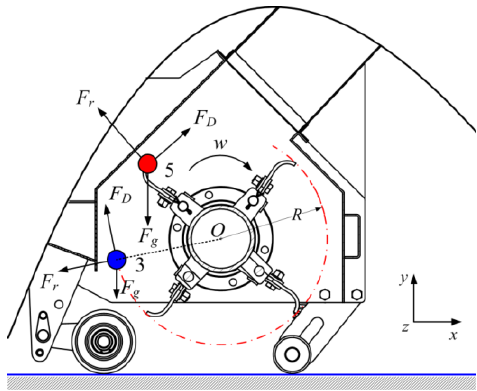
Figure 5. Static analysis of impurity particles in circular motion. Furthermore, they were mainly affected by gravity F g , drag force F D , and centrifugal force F r . The direction of drag force F D was perpendicular to the direction of centrifugal force. When there was no relative movement between impurity particle and air flow, the drag force F D would disappear. The impurity particle was only affected by gravity F g and centrifugal force F r , which could be expressed as: